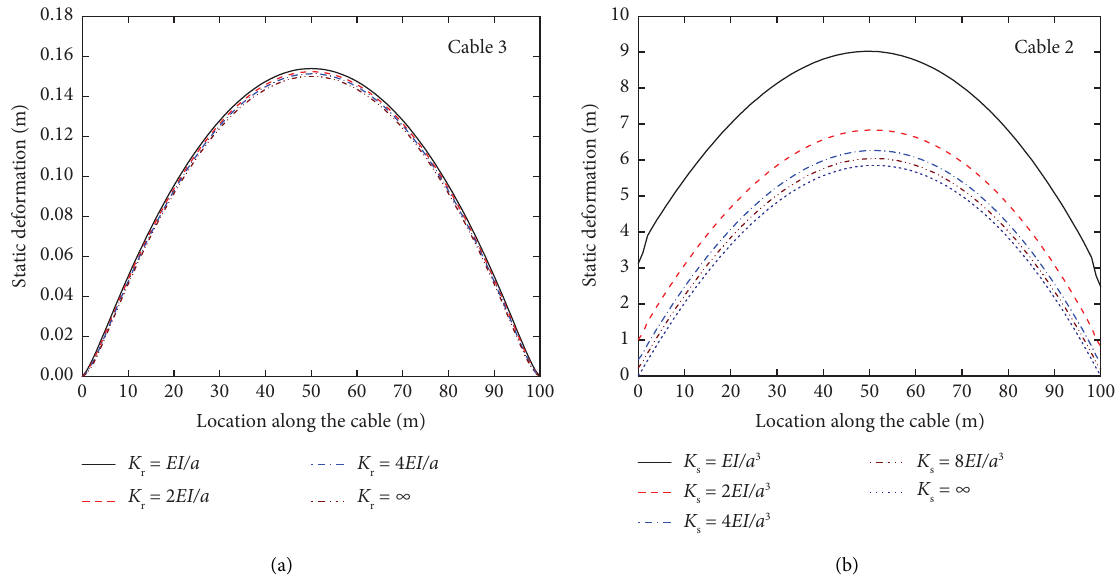
Figure 6: Infuence of (a) rotational constraint stifness K profle.